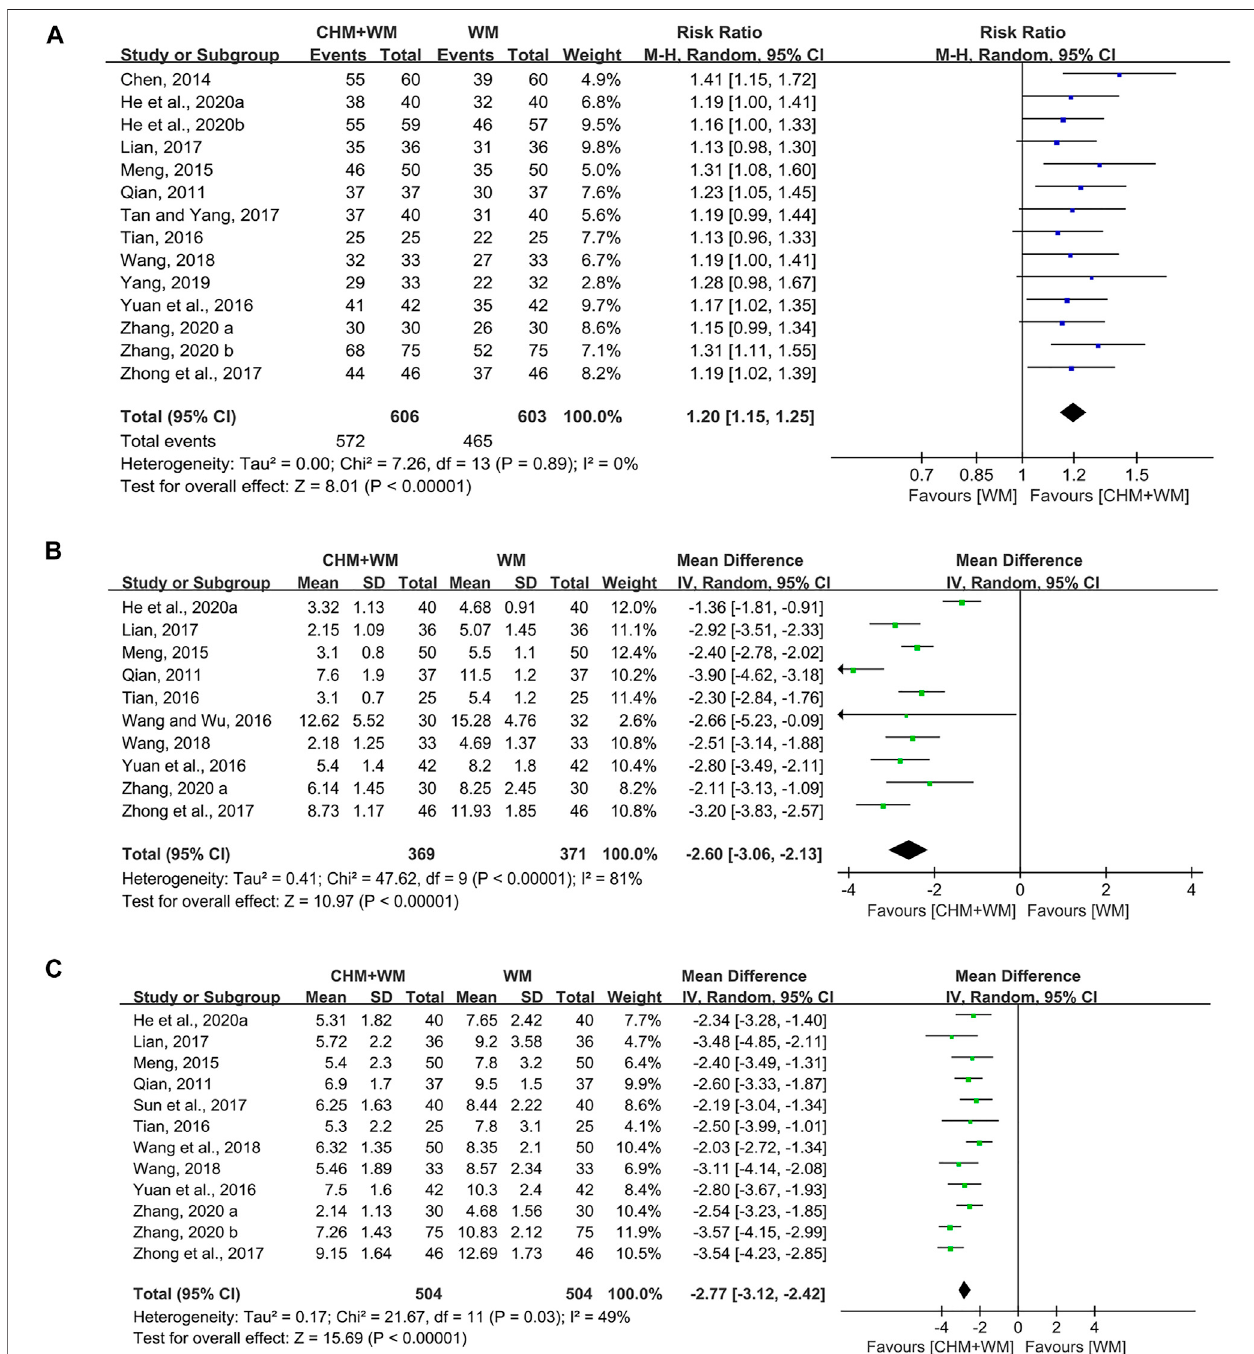
FIGURE 3 | Forest plots of primary outcomes. (A) Clinical ef fi cacy rate. (B) Antipyretic time. (C) Cough disappearance time.